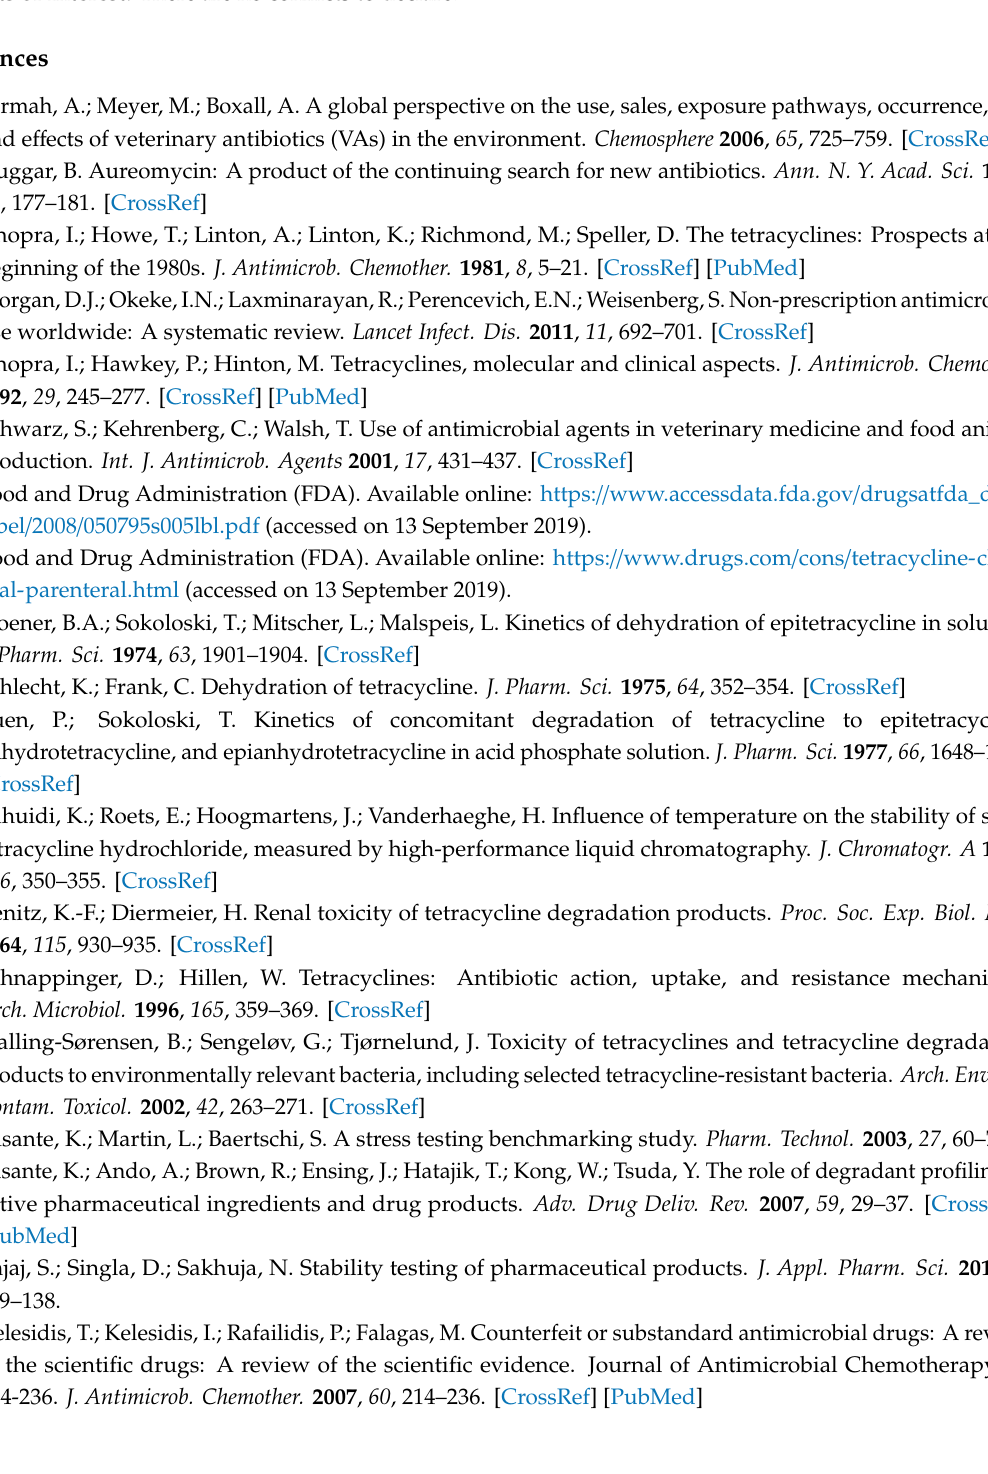
Figure S1. Alignment of the experimental FT-Raman spectra of